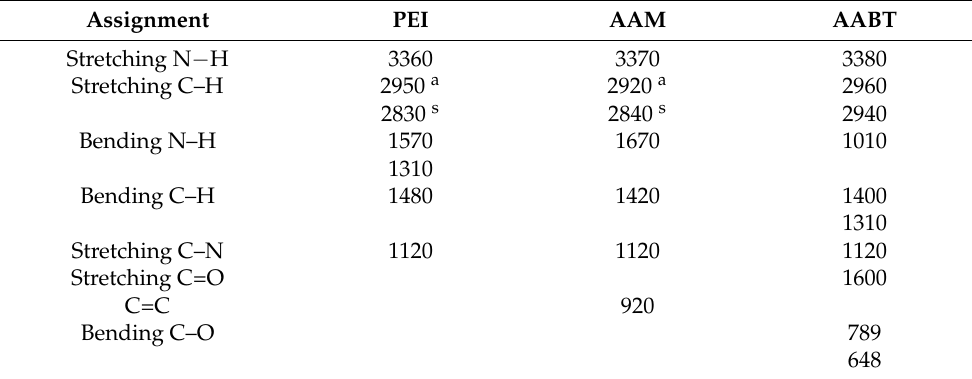
Figure 5. FTIR spectra of ( a ) AABT, ( b ) AAM, and ( c ) PEI. Table 2. FTIR spectral data (cm − 1 ) of PEI, AAM, and AABT